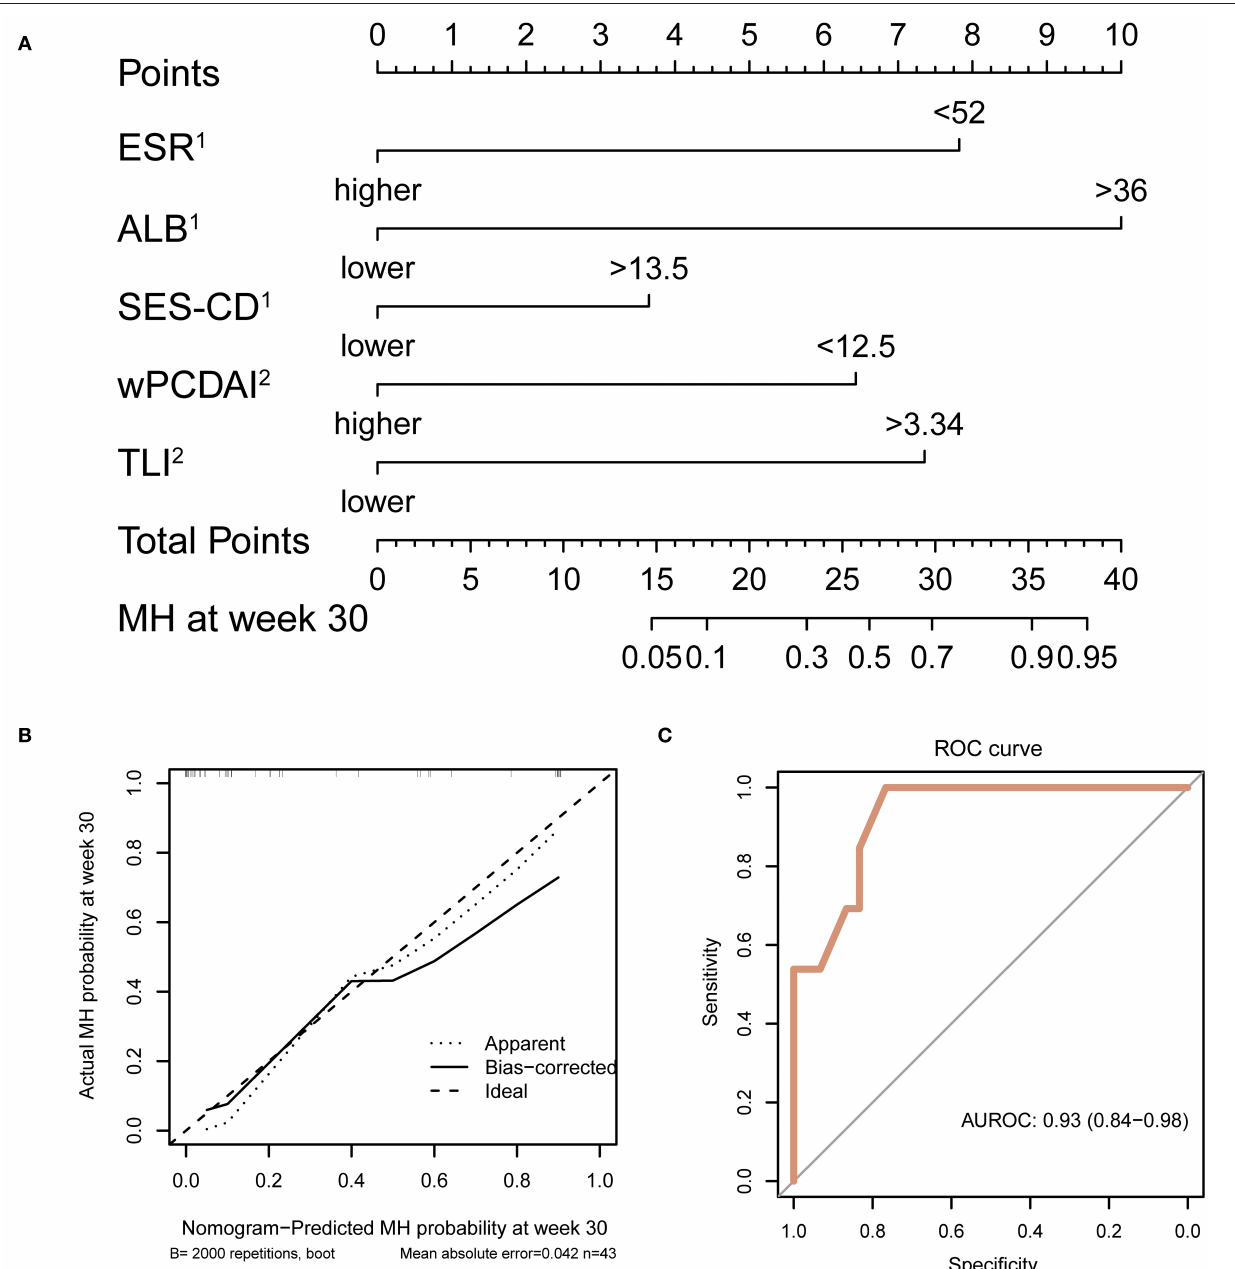
FIGURE 2 | Development, calibration, and performance of nomogram. (A) Week 30 MH nomogram. Each variable is assigned a score on the “points” axis. The sum point corresponds to the estimated probability of MH at week 30. ESR, ALB, and SES-CD were evaluated before induction treatment. wPCDAI and TLI were determined at week 14. (B) Calibration plot for internal validation of the nomogram. Curves represent observed vs. predicted probabilities. (C) ROC curve indicating the discrimination capacity of the nomogram. AUC and its 95% confidence interval were estimated by bootstrap resampling with 2,000 repetitions. MH, mucosal healing; ESR, erythrocyte sedimentation rate; ALB, albumin; SES-CD, Simple Endoscopic Score for Crohn Disease; wPCDAI, weighted Pediatric Crohn’s Disease Activity Index; AUC, area under the curve.